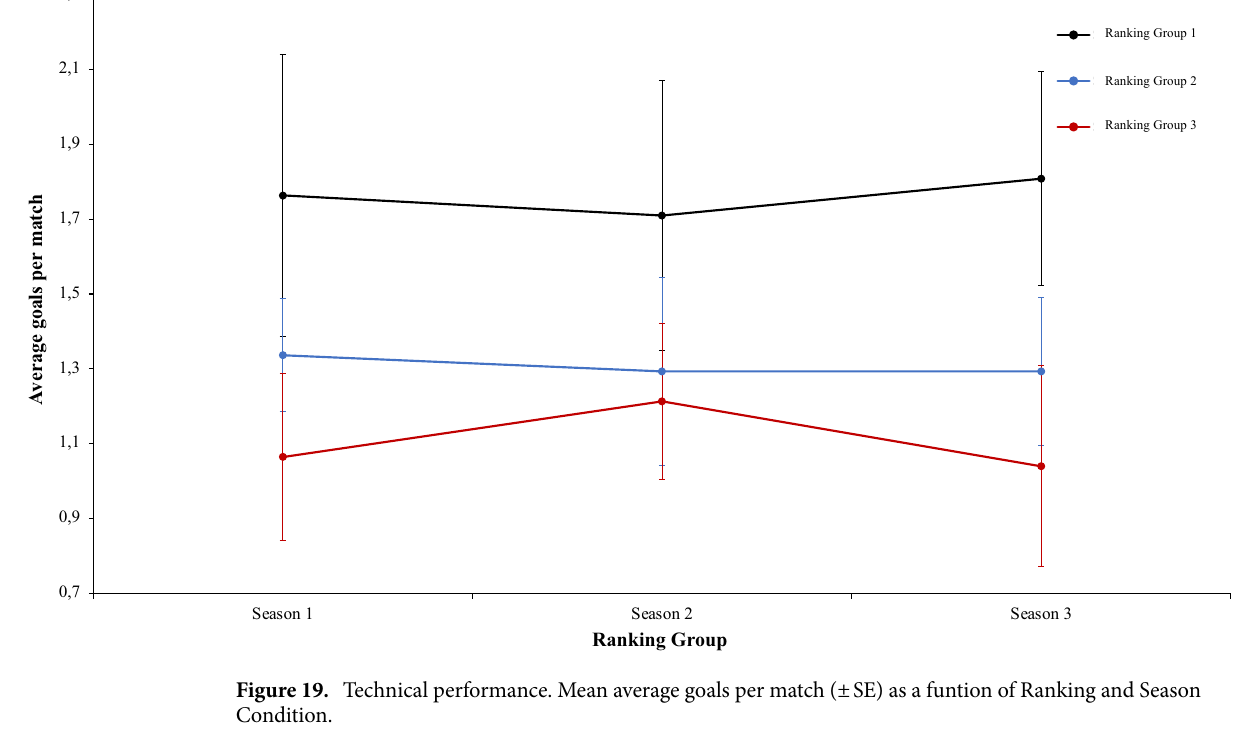
Figure 19. Technical performance. Mean average goals per match (± SE) as a funtion of Ranking and Season Condition.